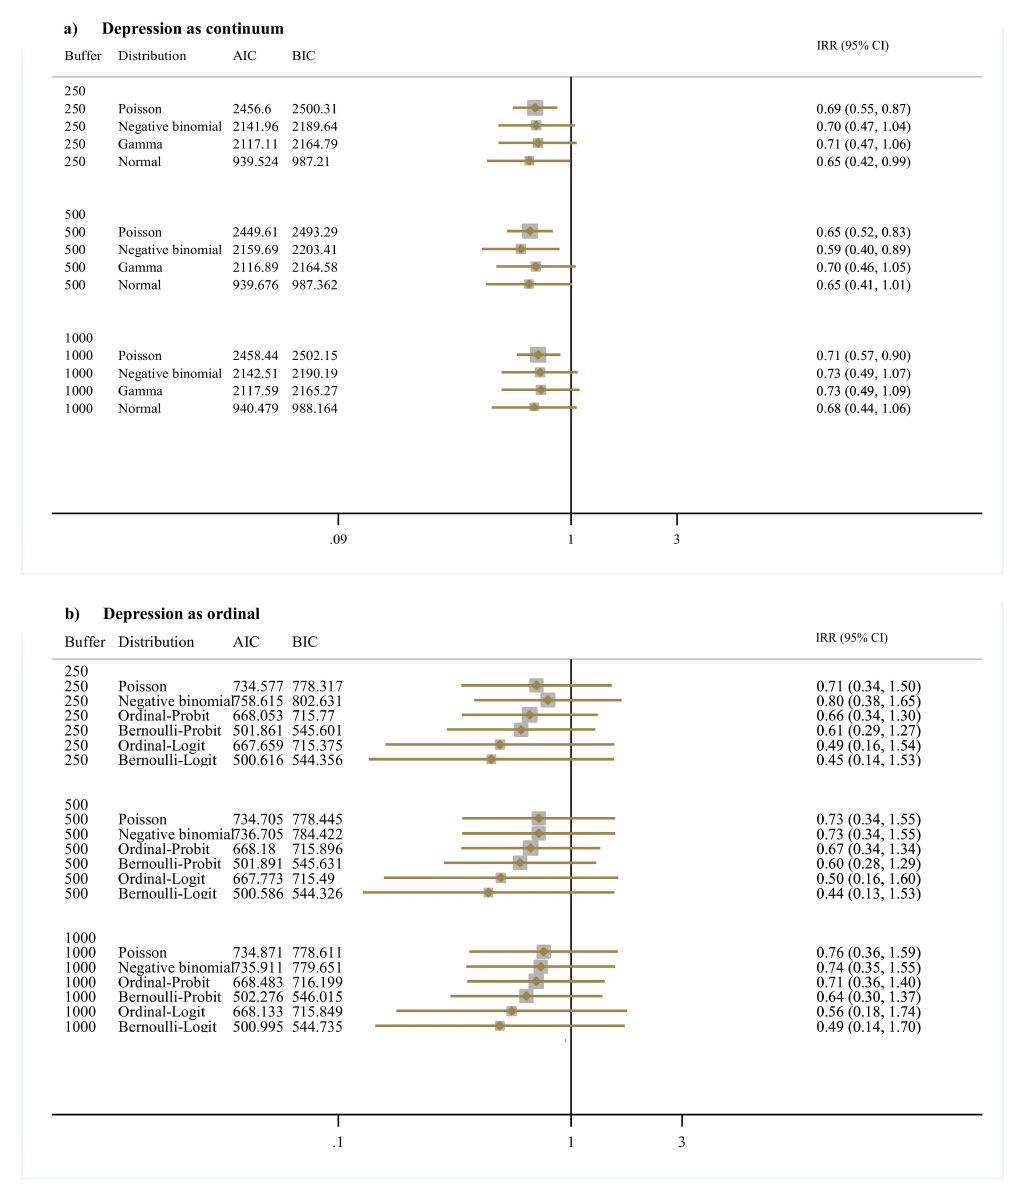
Figure 3. Direct association between depression as ( a ) continuum and ( b ) ordinal variable and brownness summarized at bu ff er sizes of 250 m, 500 m, and 1000 m. Note: Bu ff er indicates distances in meters around the geocoded address of residence of each study participant. Distribution indicates the distribution in which depression was modeled. When the normal distribution was assumed the values of depression were log transformed. AIC corresponds to the Akaike information criterion results and BIC to the Bayesian information criterion results. IRR are incidence rate ratios. CI is confidence interval. All models were adjusted by Age, Sex, Healthy-food index, Physical-Activity index, Body mass index, Household income, Adverse Childhood Experiences, Social support index, and Peer alienation